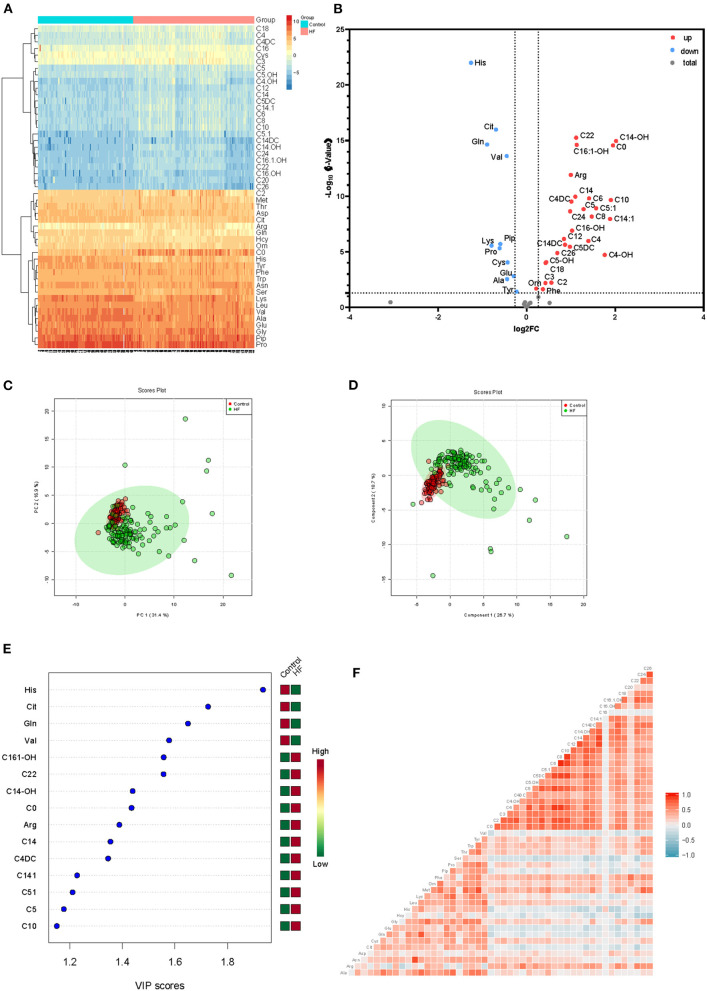
(A) Heatmap of significantly differential metabolites between HF patients and control group, depicting the levels of metabolites in each sample and the variation in each metabolite between samples, ranging from blue (low intensity or downregulation) to yellow and red (high intensity or upregulation). (B) Volcano plot for significantly differentially metabolites between the two groups. Red dots indicate that the metabolite was significantly changed in terms of the P-value and log2 fold-change value; gray circles indicate that the metabolite level was not significantly altered in terms of P-value. (C) PCA and (D) PLS-DA analysis of 49 metabolites, the green dots represent HF patients while the red dots represent control group. (E) VIP scores of differential metabolites. (F) Correlation analysis of all metabolites, ranging from blue (low correlation) to red (high correlation).